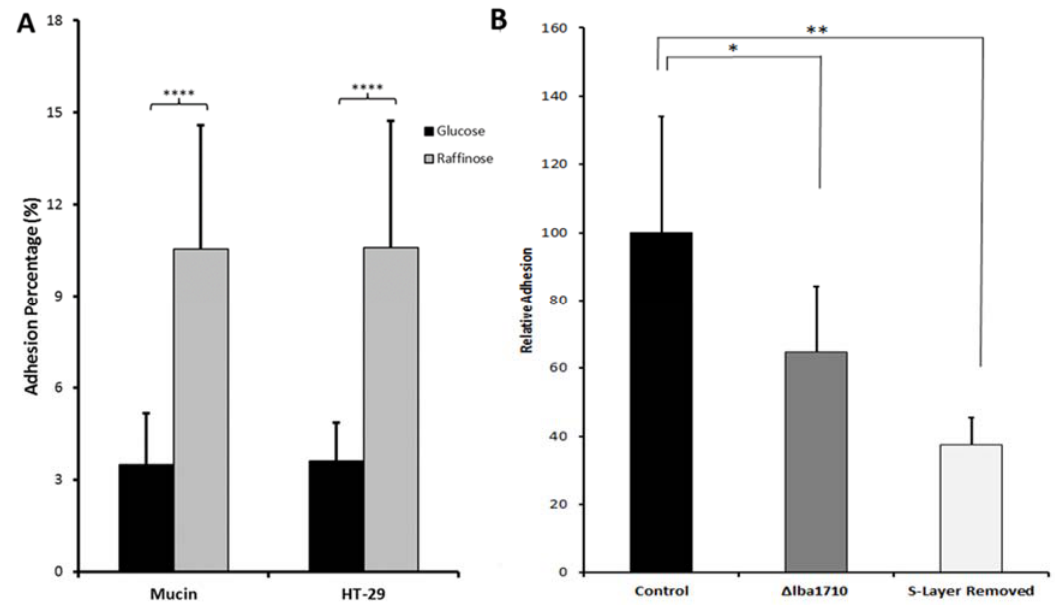
Figure 4. In vitro adhesion of Lactobacillus acidophilus NCFM to mucin and HT ‐ 29 cells. ( A ). Bacteria grown with glucose (black) and raffinose (grey). ( B ). Adsorption to mucin of wild type grown on raffinose (black), a thermostable pullulanase deletion mutant ( Δ lba1710) (grey), and surface depleted wild type (white). Modified from Reference [44].